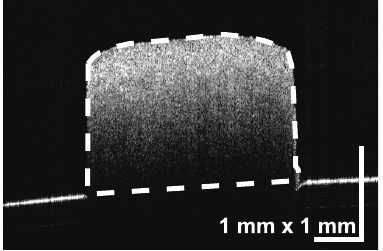
Figure 3. An OCT image with a rubber plate used for the measurement of the cross-sectional area. The area between the sample surface and the surface of the rubber plate behind the sclera, which is defined by line interpolation from the exposed surface of the rubber plate, was defined as the cross-sectional area.